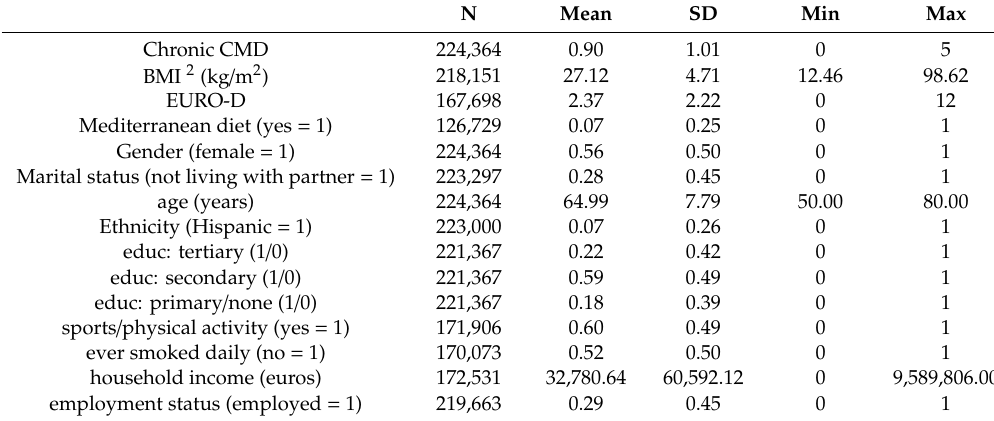
Table 1. Descriptive statistics of key variables 1 .